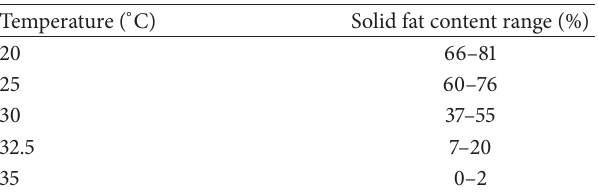
Table 1: Solid fat content of cocoa butter (adapted from the data of Beckett